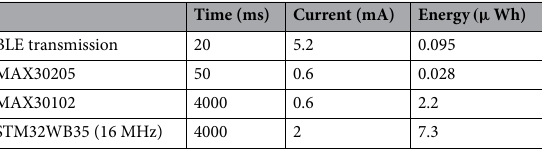
Table 4. Overview of power consumption for the proposed application with V DD = 3.3